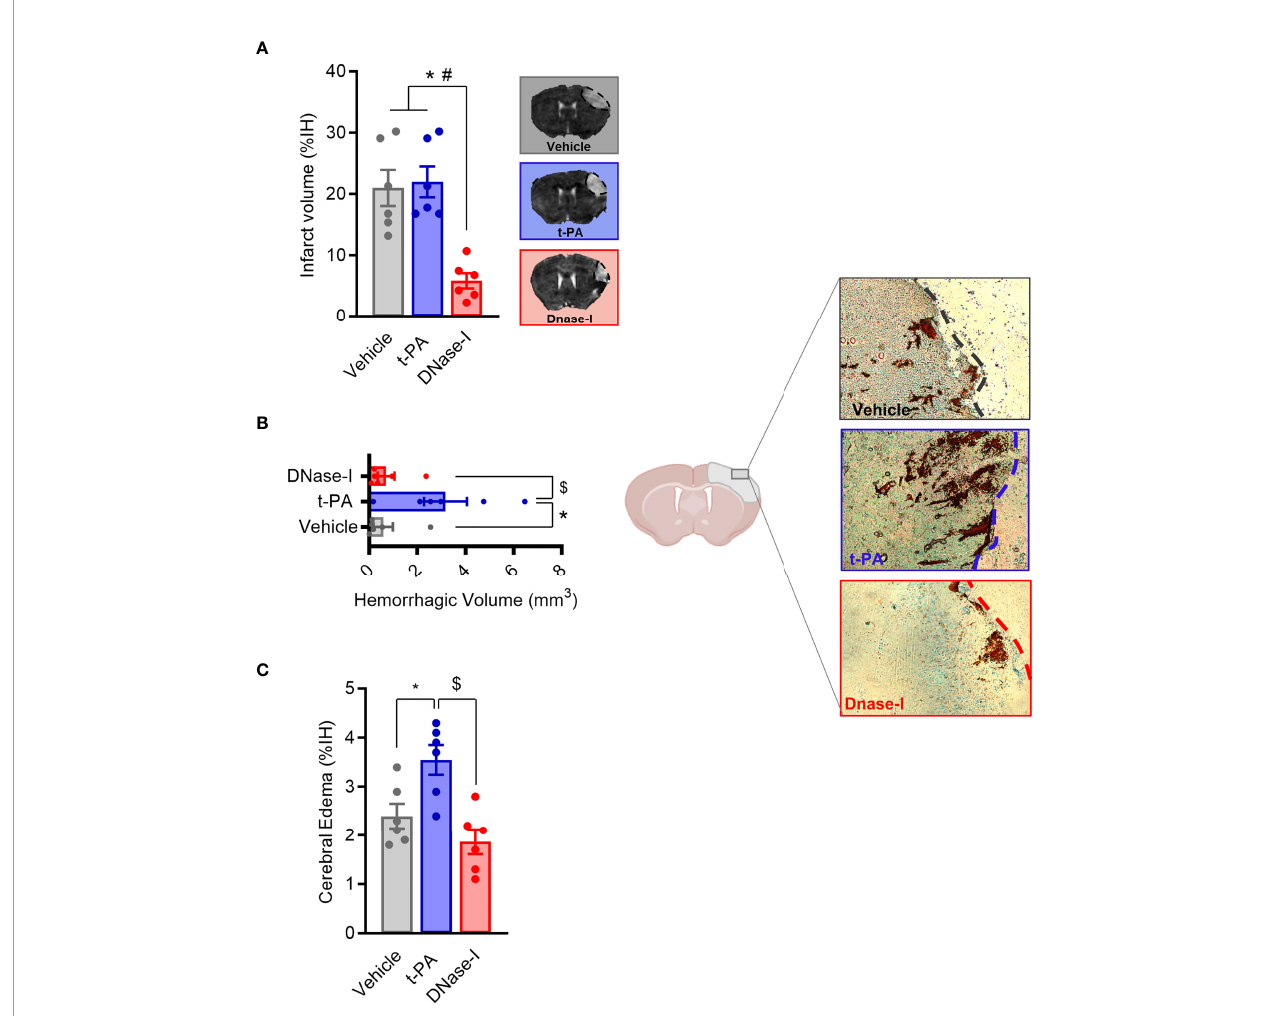
FIGURE 2 | Effect of t-PA and DNase-I treatments administrated 3 hours thromboembolic occlusion. (A) Infarct volume determined 24 hours after the occlusion. (B) Hemorrhagic volume (mm 3 ). (C) Cerebral edema. Data are mean± SEM (n = 6 *p < 0.05 vs vehicle; # p < 0.05 tPA vs DNase-I; $ p < 0.05 tPA vs